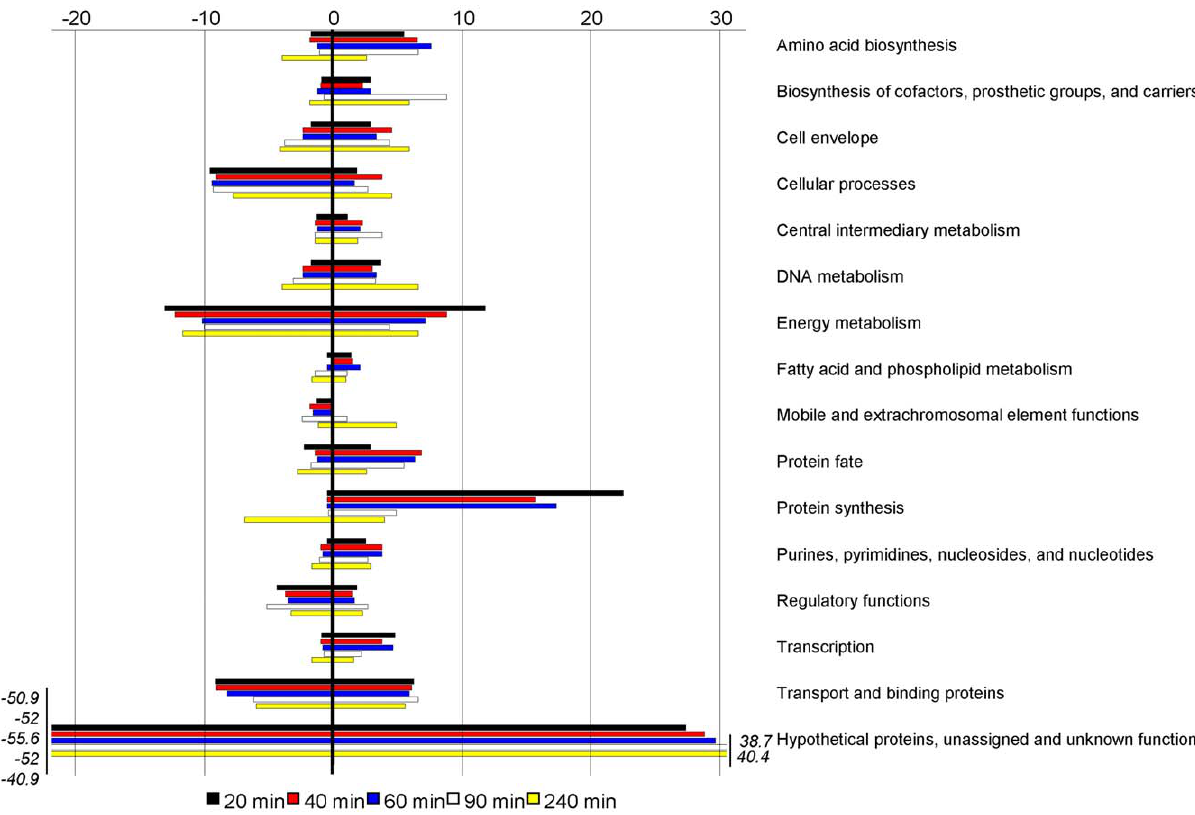
Figure 7. Detection of NMB0390 on the surface of meningococci by FACS. Meningococcal strain MC58 were recovered from human blood (donor A) after 0, 90 and 240 min of cultivation.